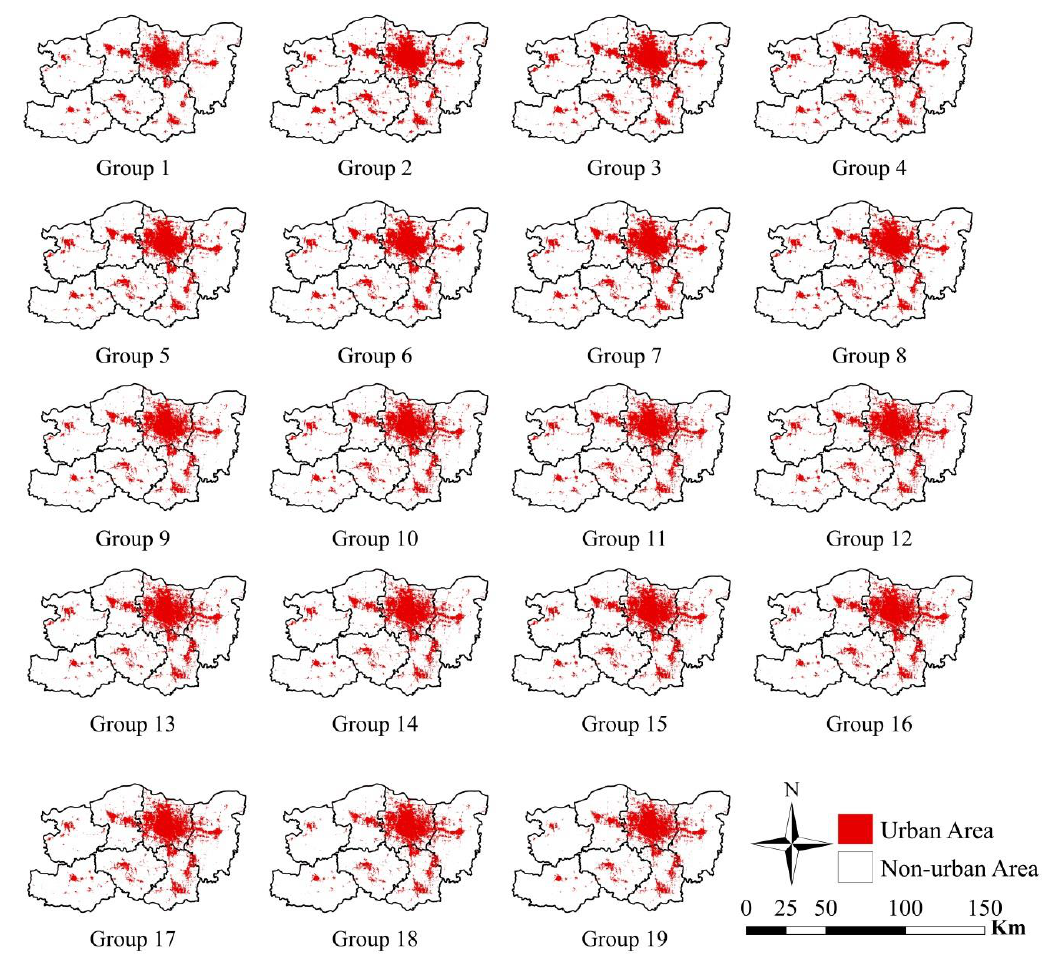
Figure 5. Classification based on different samples for training.